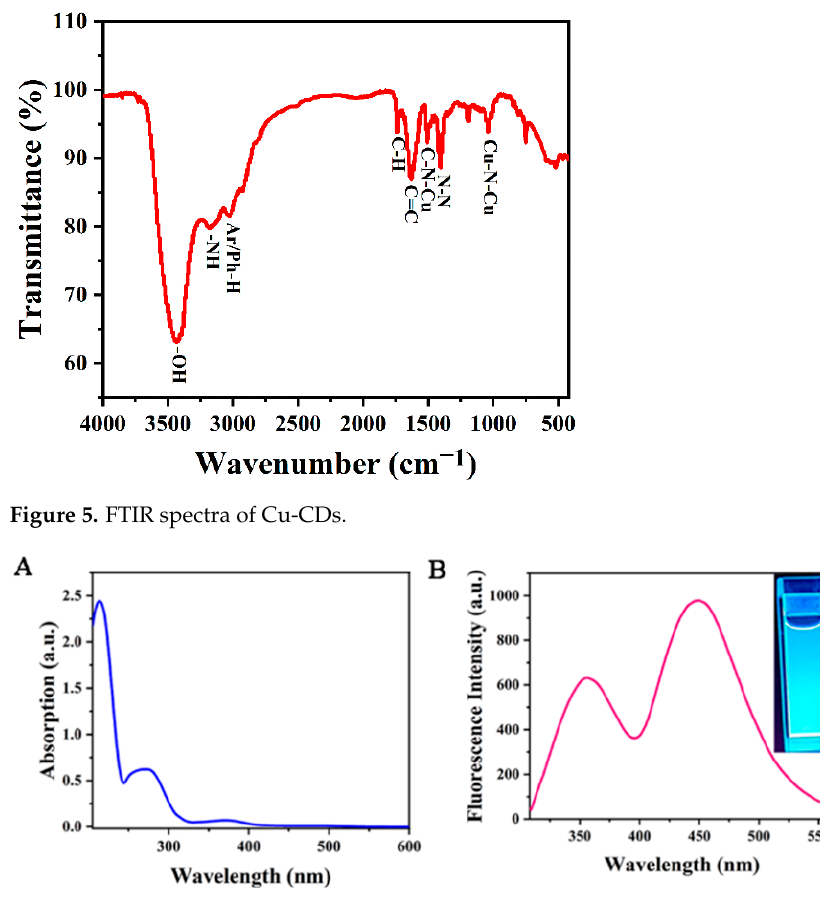
Figure 6. UV–visible absorption spectra ( A ) and fluorescence emission spectra ( B ) of Cu-CDs.